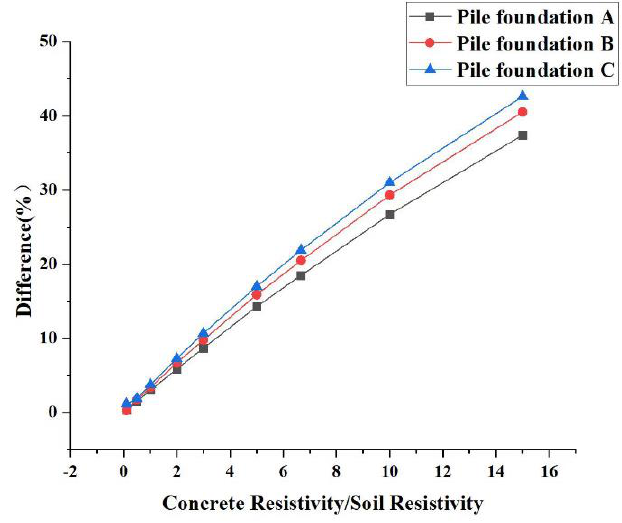
Figure 5. Percentage difference of foundation equivalent radius with different number of main rebars. Table 6. Power frequency grounding resistance of the pile foundation A.